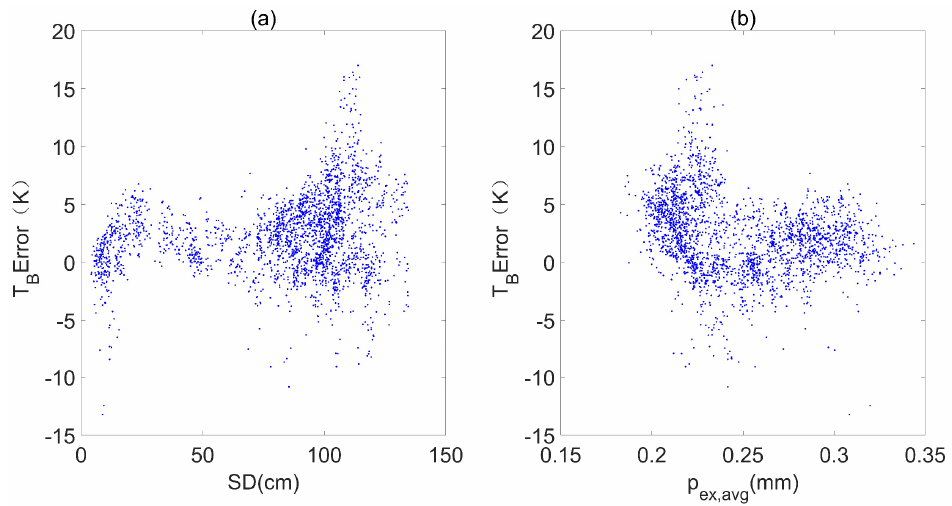
Figure 16. Sensitivity of brightness temperature (T B ) Error to snow depth (SD) ( a ) and mass-weighted average exponential correlation length ( p ex,avg ) ( b ) using cut-off threshold (CR) of 1/ e at 36.5 GHz, vertical polarization and a 55° incidence angle. Table 7. Error statistics for the MEMLS-simulated multiple-layer brightness temperature (T B,Multi-layer ), MEMLS-simulated single-layer temperature (T B,Bulk ) and brightness temperature measured by ground-based radiometer (T B,Measured ). Error (K)